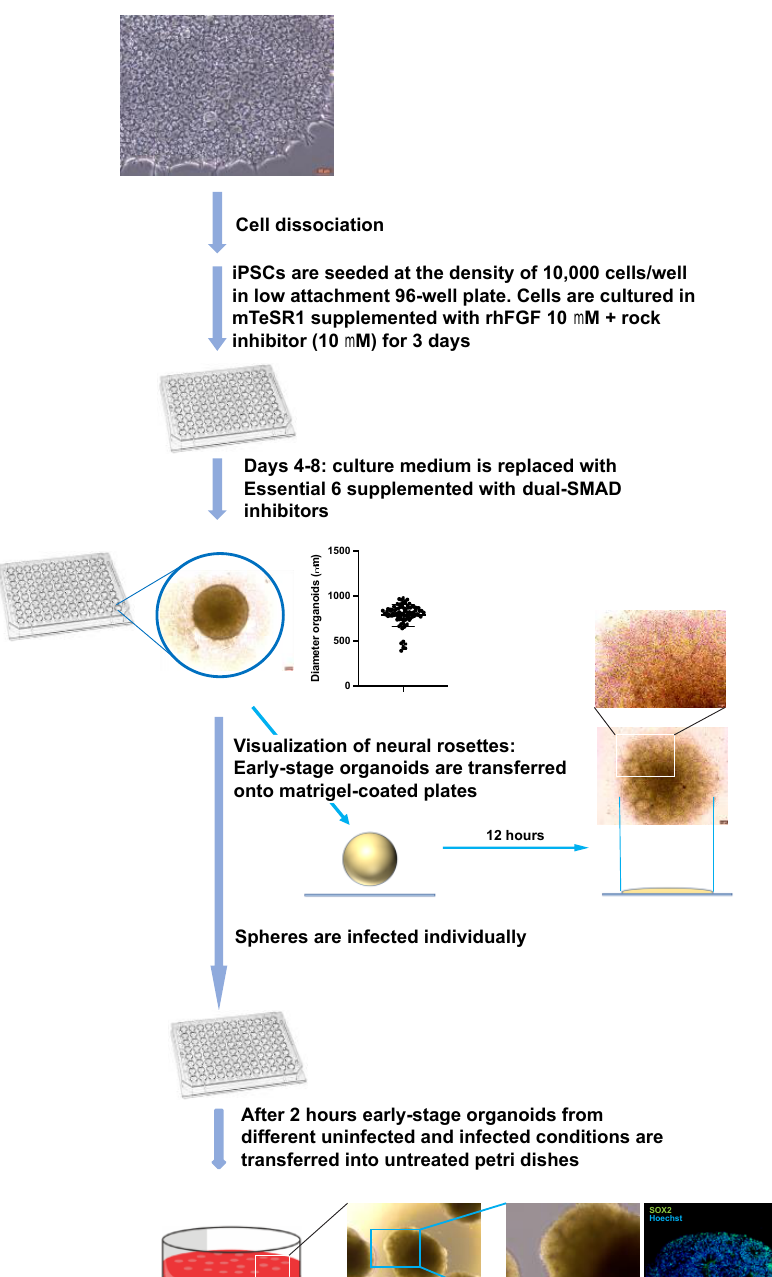
Figure 2. Generation and infection of early-stage brain organoids derived from embryoid bodies. iPSCs were seeded at the density of 10,000 cells in low attachment 96-well plate and cultured in the presence of ROCK inhibitor and rhFGF for the generation of embryoid bodies (EBs). After 3 days the EBs were exposed to dual-SMAD inhibitors for 5 days to induce the formation of neuroectoderm. After this, the differentiating EBs were mainly composed of neural rosettes. The average diameter of this early organoids (determined by measuring the diameters of 89 organoids) was 788.4 mm (SD = 124.5). Early organoids were infected individually in each well of the 96-well plates with 1000 pfu of HSV-1 strain KOS in the presence or absence of ACV. After 2 h, the inocula were removed, the early organoids washed and transferred into 10-cm untreated petri dishes for further differentiation. Microphotographs of ES-organoids after being transferred into petri dishes and staining for the NPC marked SOX2 are depicted in the bottom-most panel.